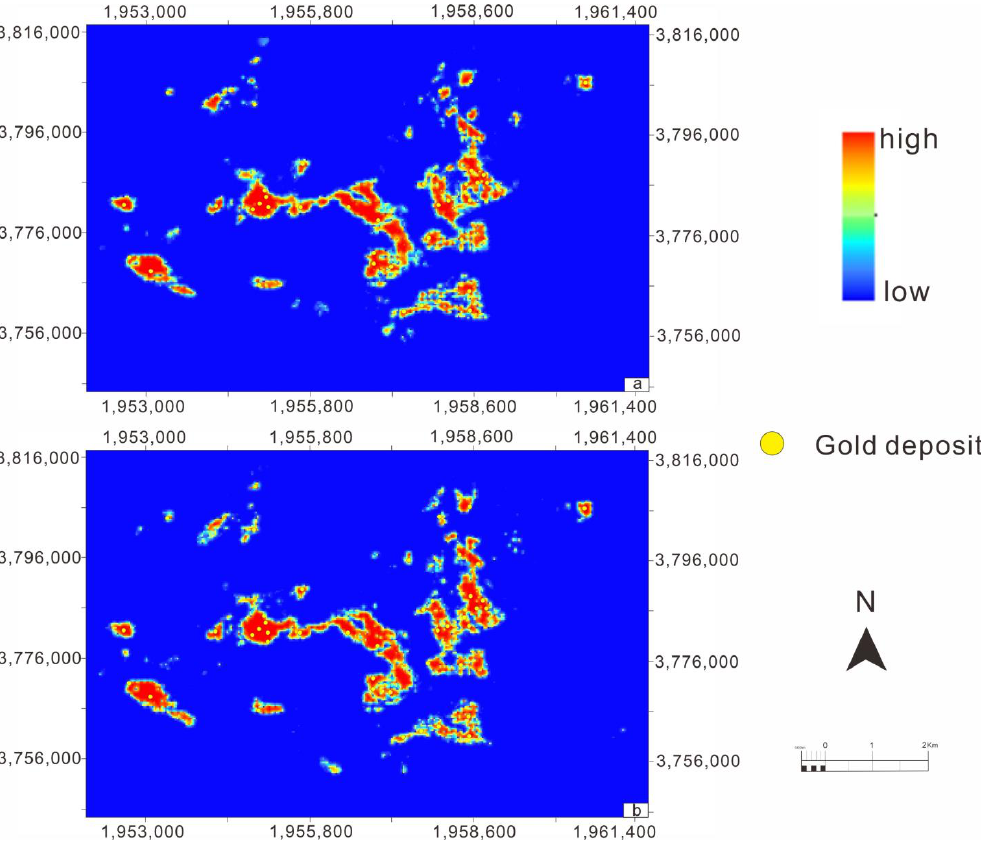
Figure 11. Predictive models of mineral prospectivity derived by: ( a ) random search-GBDT; and ( b ) TPE-GBDT models.